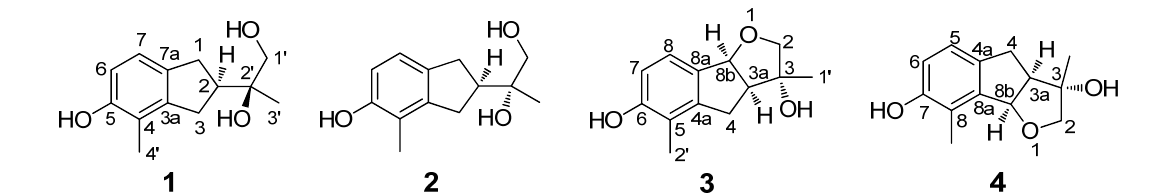
Figure 1. Structures of the novel indanes ( 1 – 4 ) isolated from A. tanguticus .